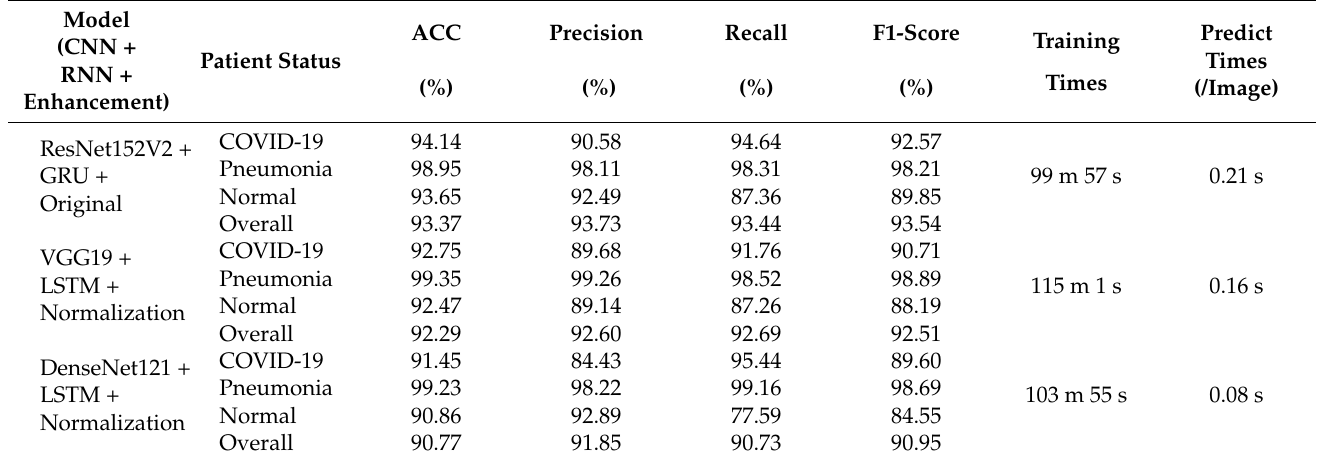
Table 2. Comparison of CNN–RNN models for multi-classification